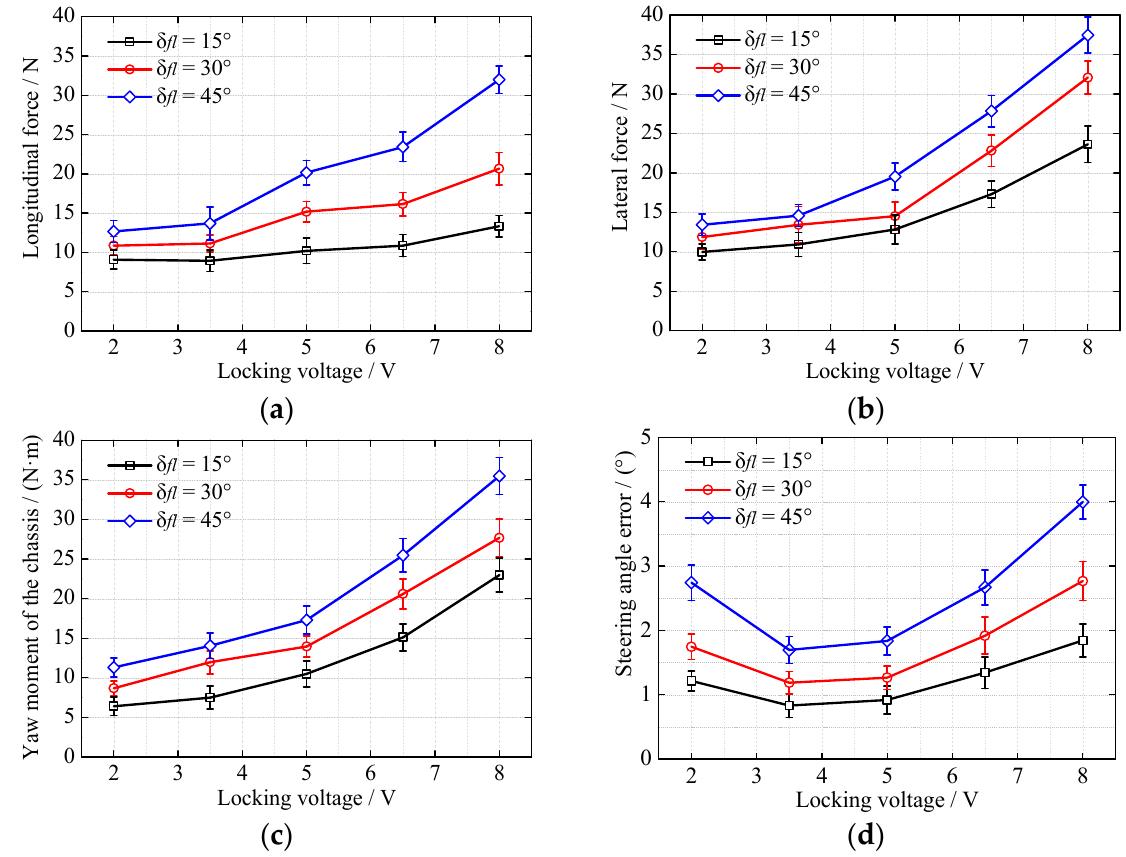
Figure 6. Impact of the locking voltage on ( a ) Longitudinal force; ( b ) Lateral force; ( c ) Yaw moment; ( d ) Steering errors.